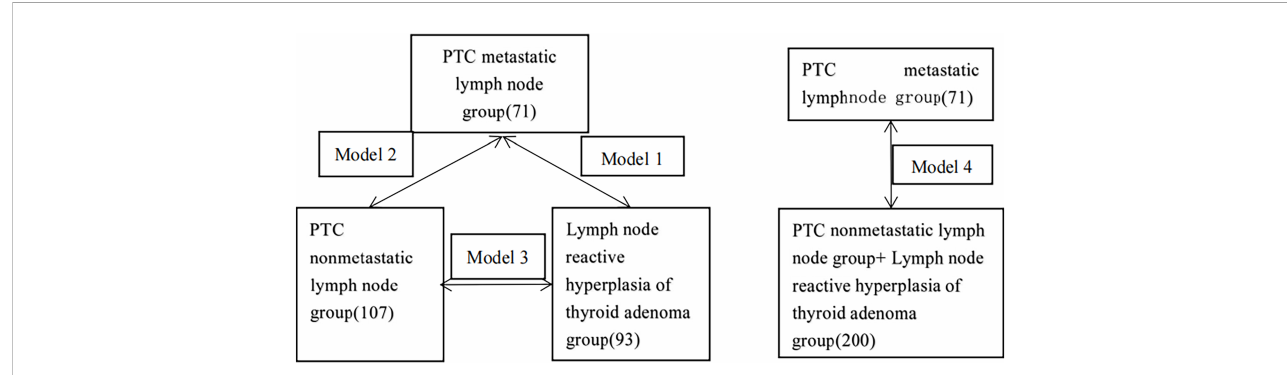
FIGURE 2 Schematic diagram of model construction.